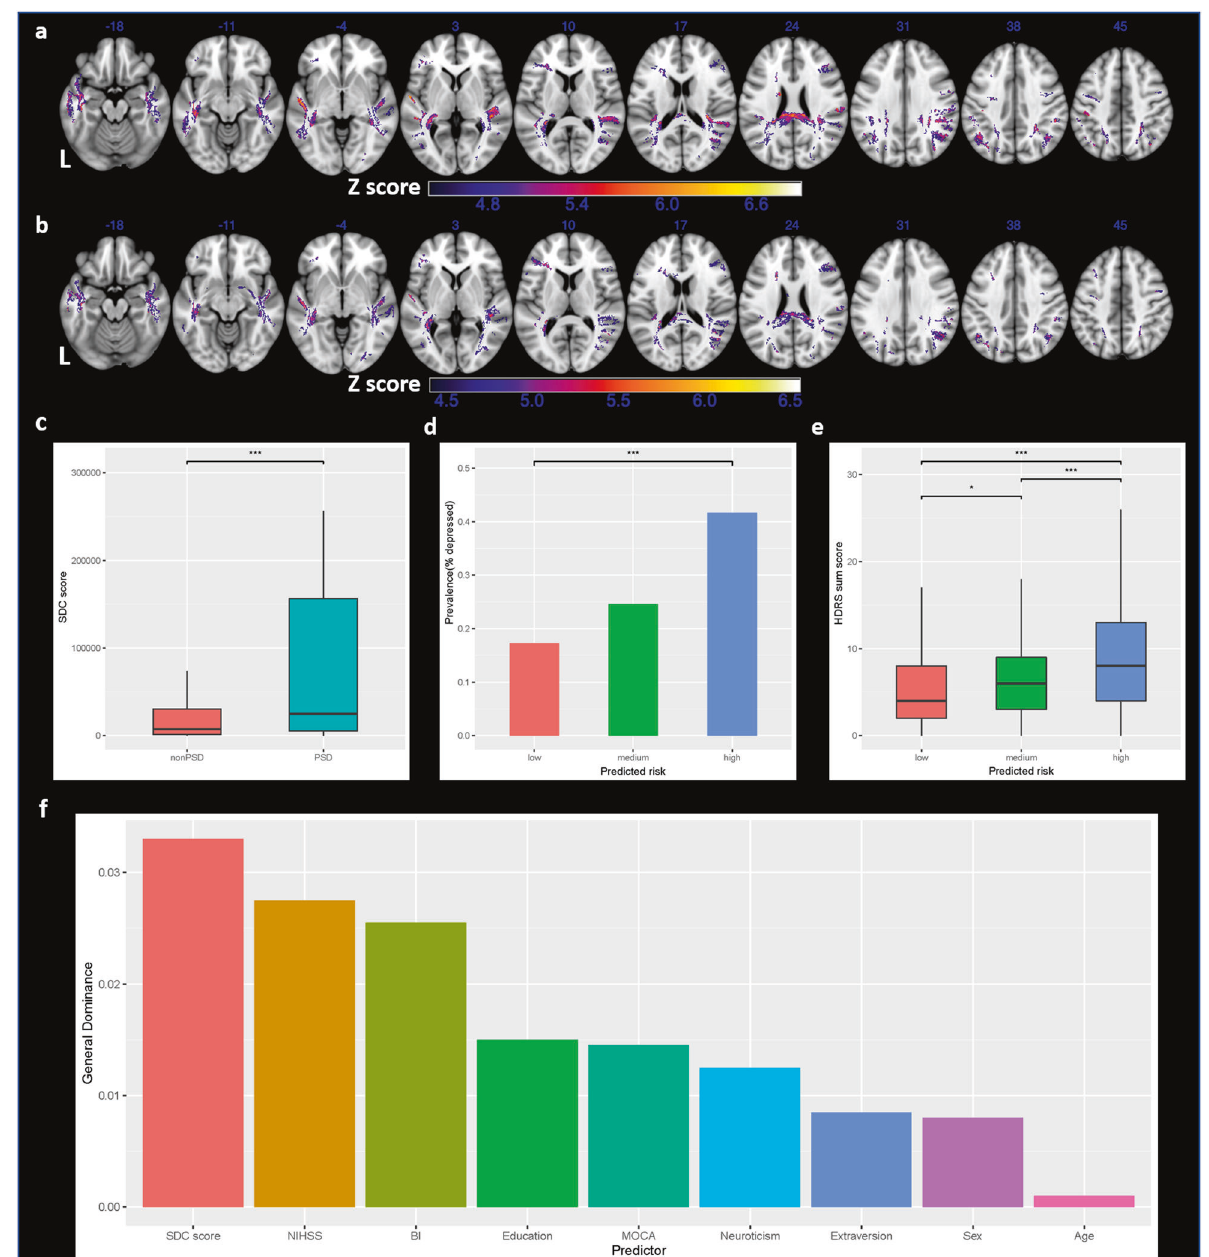
Fig. 3 Results of split-half analysis. a , b VDSM results from dataset 1 and dataset 2, respectively; c SDC score compared between PSD and non-PSD; d true PSD prevalence compared among three risk groups de fi ned by SDC score tertiles; e true PSD severities compared among three risk groups de fi ned by SDC score tertiles; f averaged predictor importance of two enhanced models. Axial coordinates refer to MNI space in mm. L indicates left.